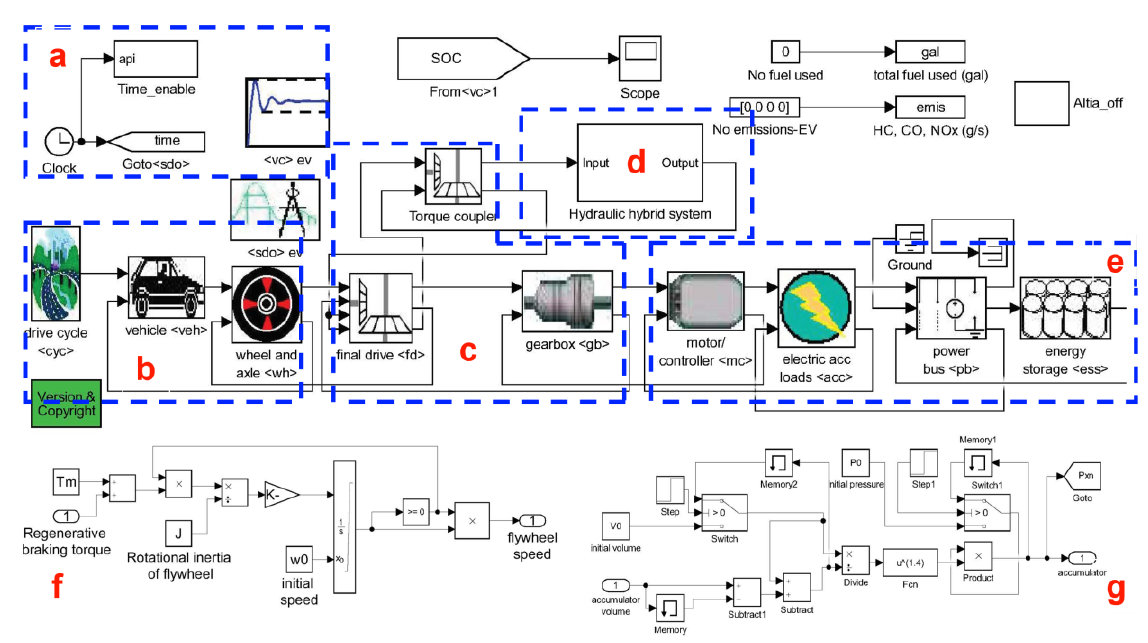
Figure 9. The electric vehicle model combined with the proposed HRBS model: ( a ) vehicle control system; ( b ) driving condition system; ( c ) vehicle transmission system; ( d ) hydraulic hybrid system; ( e ) electric vehicle system; ( f ) flywheel subsystem; ( g ) accumulator subsystem.